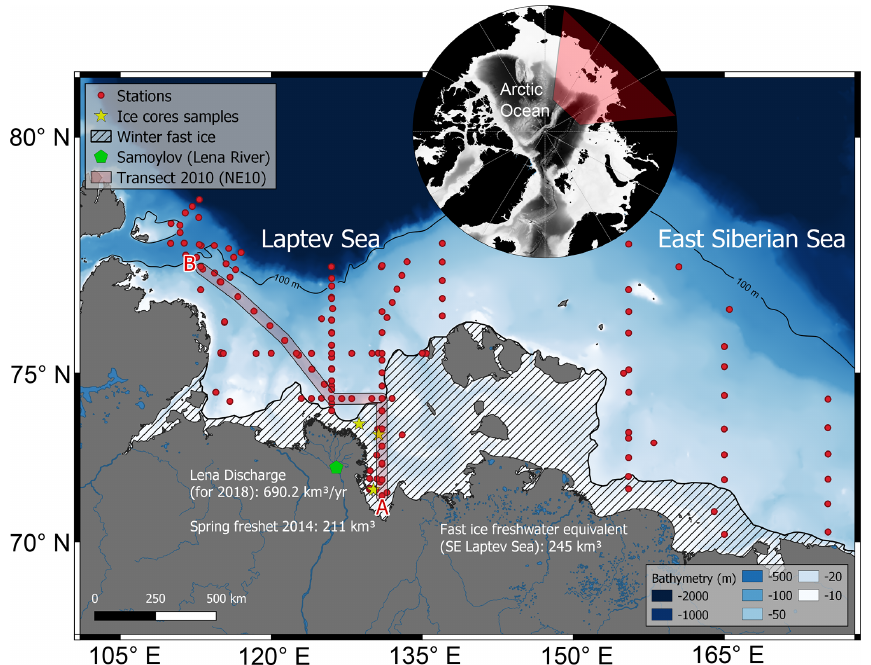
Figure 1. Map of the Laptev (LS) and East Siberian (ESS) seas and station distribution during the ship-based expeditions in summer (red dots). The border between the LS and the ESS runs along 140 ◦ E. The LS was sampled in 2010, 2011, 2013, 2014, 2018 and 2019. Only a few stations could be repeatedly sampled in multiple years. The ESS was sampled in 2019. Maps of the stations of each expedition with a detailed description of the location and date are available under the respective data sets (Table 1; Hölemann et al., 2020a–g; Kattner et al., 2010). In addition, samples of land-fast ice (fast ice) and the water column were taken from March to April 2012 (yellow stars). The extent of fast ice describes the situation on 1 May 2011. The grey line between A and B represents the oceanographic transect shown in Fig. 6. Bathymetric data were provide by IBCAO V3 (Jakobsson et al., 2012). Table 1. Expedition data and the number of samples (#) used in this study. The data are accessible on PANGAEA. Campaign Region Month #CDOM